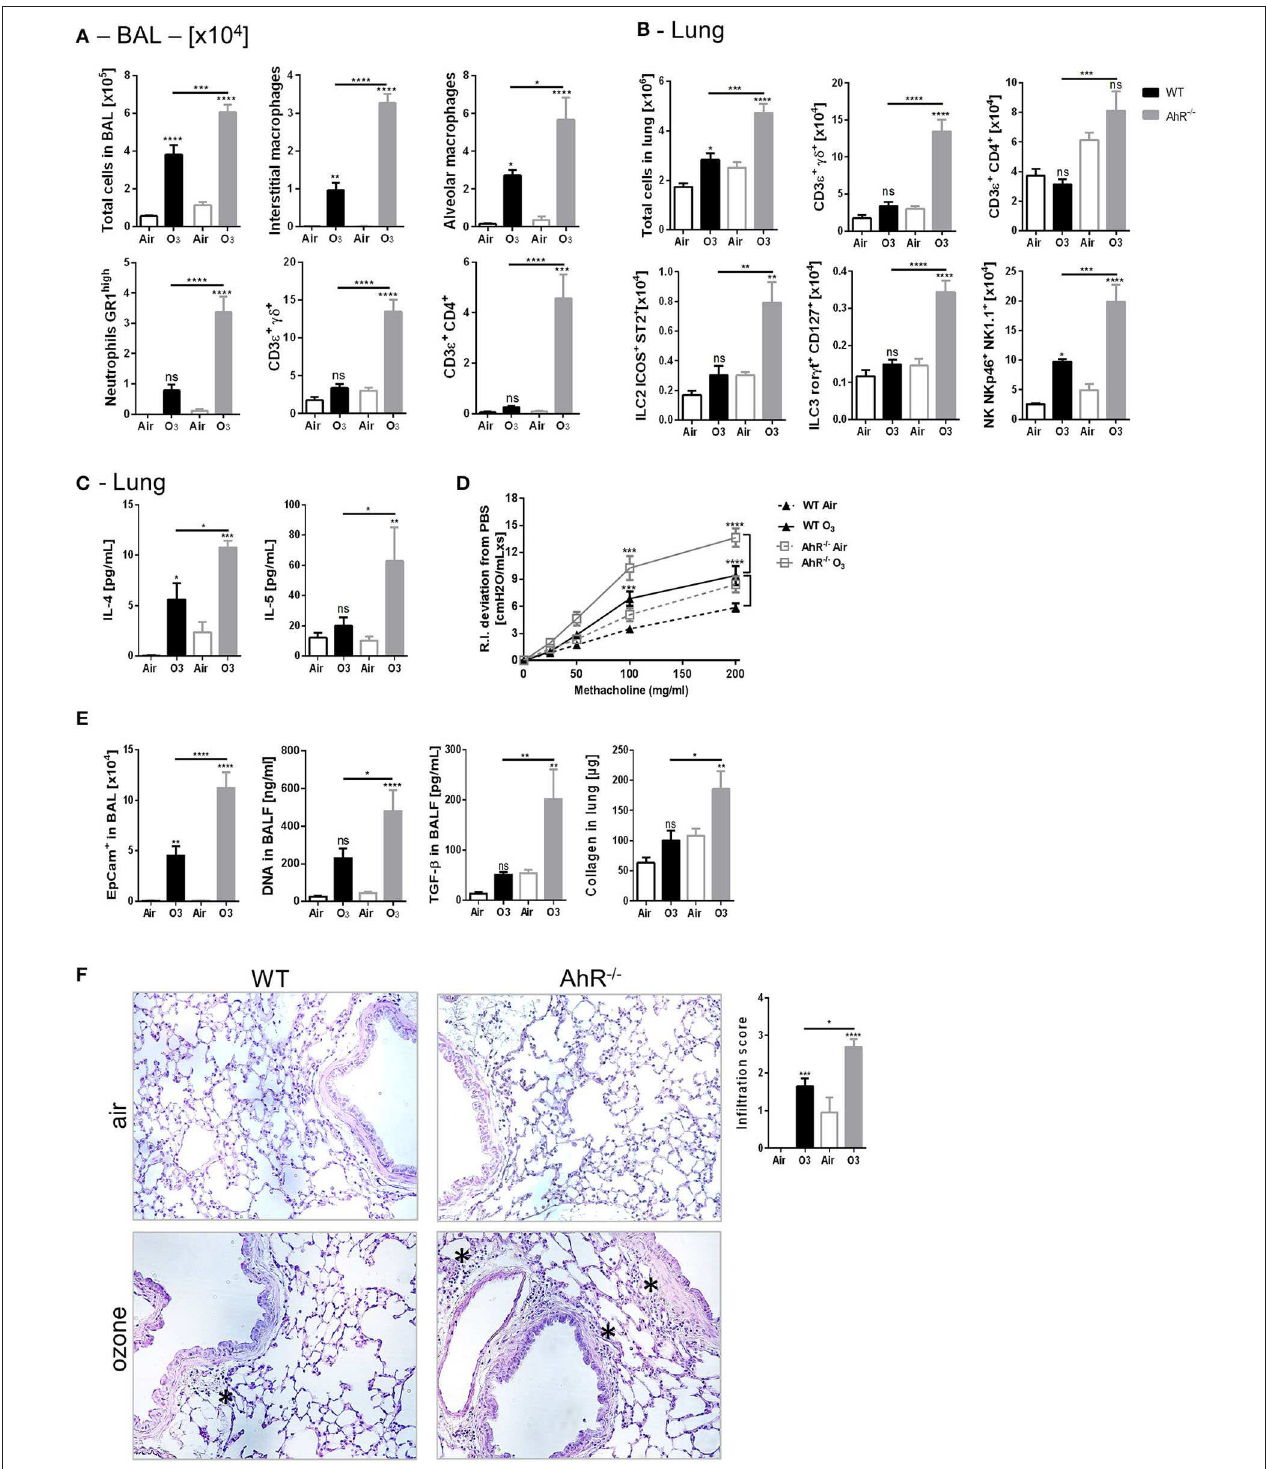
FIGURE 2 | Inflammation, AHR, and remodeling parameters in AhR deficient mice. BAL cells recruitment (total cells, macrophages, neutrophils, and T cells) (A) . Lung cells recruitment (total cells, neutrophils, macrophages, ILC2, ILC3, αβ , and γδ T cells) (B) , T H 2 cytokines (IL-4, IL-5) (C) , AHR (D) , and remodeling parameters (epithelial cells, DNA, and TGF- β in BAL; collagen in lung) (E) ; lung histology representative pictures (400 × magnification, asterisk show cell infiltration) and cell infiltration score (F) after ozone exposure in WT and AhR deficient mice. The data are representative for one of two independent experiments with n = 5–6 mice per group. Values are expressed as mean ±